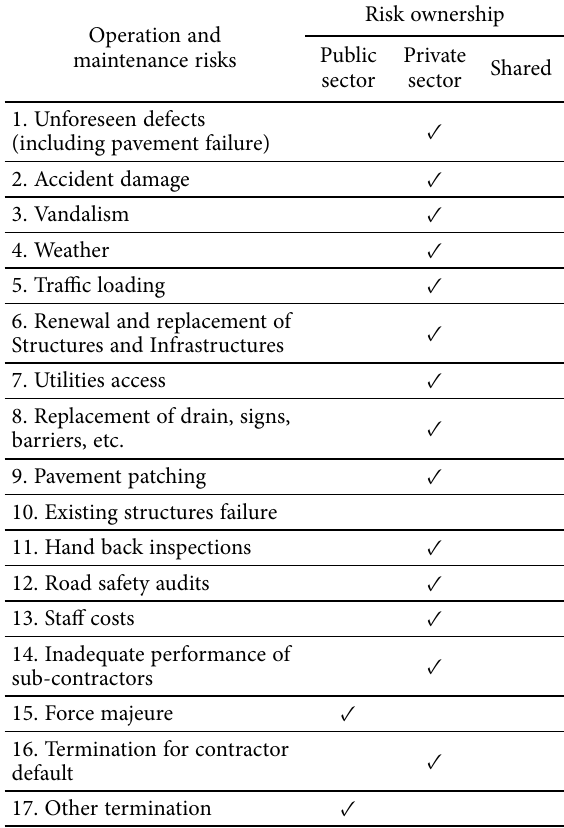
Table 5. Typical physical performance and functional performance risks in A92 PFI road project (Eaton, Akbiyikli